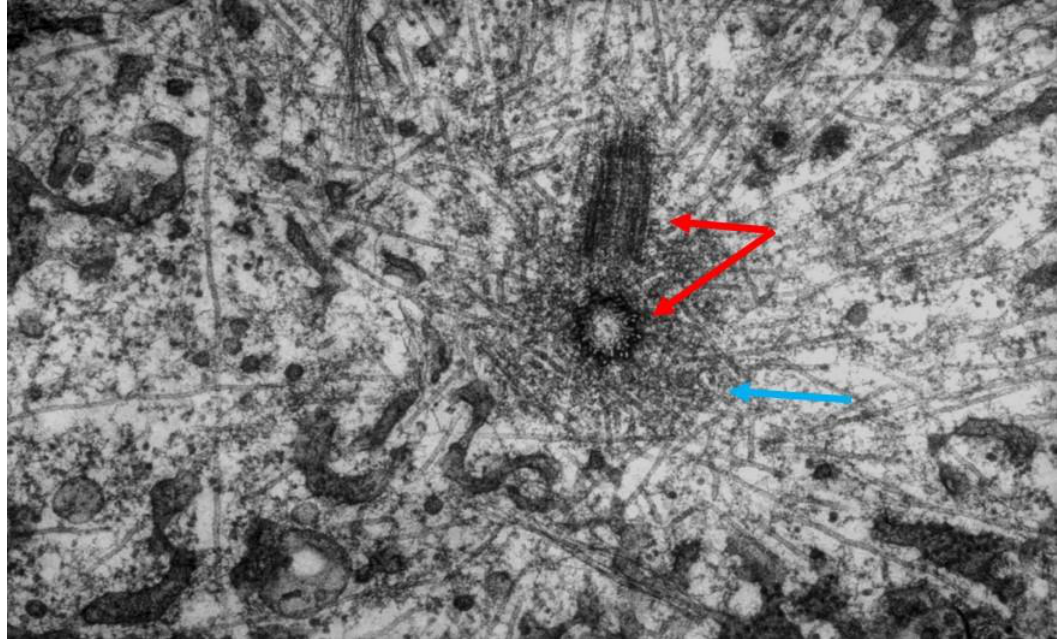
Figure 8. Electron micrograph of a mitotic spindle pole in a cultured mammalian cell, fixed with glutaraldehyde. Red arrows mark centrioles, the blue arrow indicates pericentriolar material where MTs are nucleated. Image kindness of Kent McDonald, Univ. California, Berkeley.